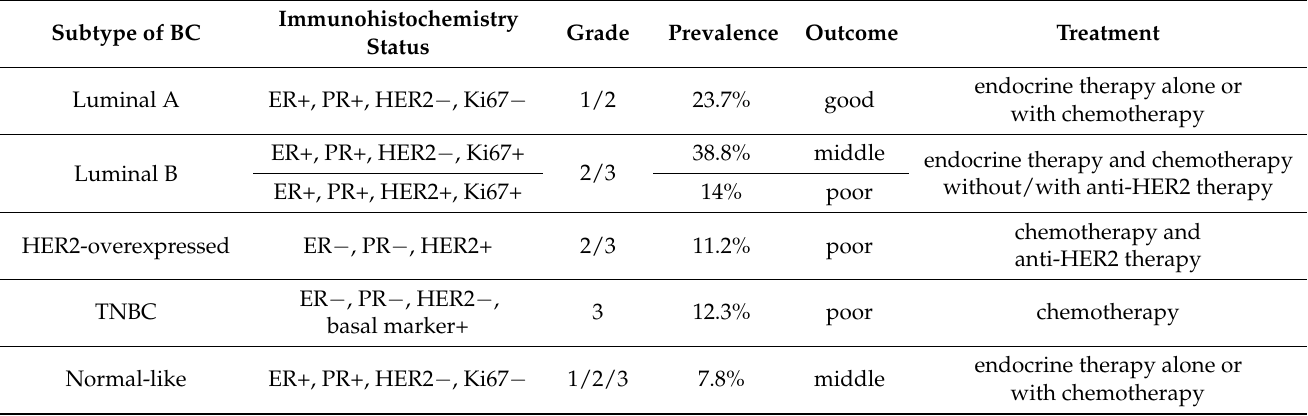
Table 1. Molecular subtypes of breast cancer (BC—breast cancer, ER—estrogen receptor, PR—progesterone receptor, HER2— human epidermal growth factor receptor, Ki67—proliferation index marker, TNBC—triple negative breast cancer)